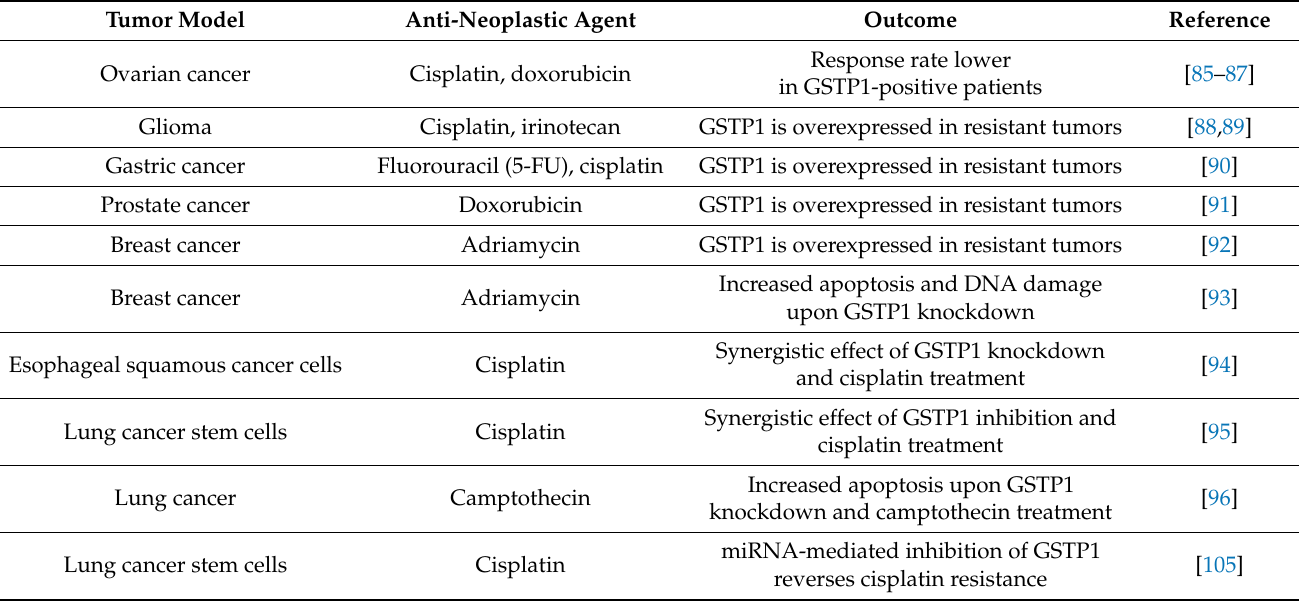
Table 1. The role of glutathione S-transferases (GST) proteins in the chemoresistance of different cancer model systems is summarized